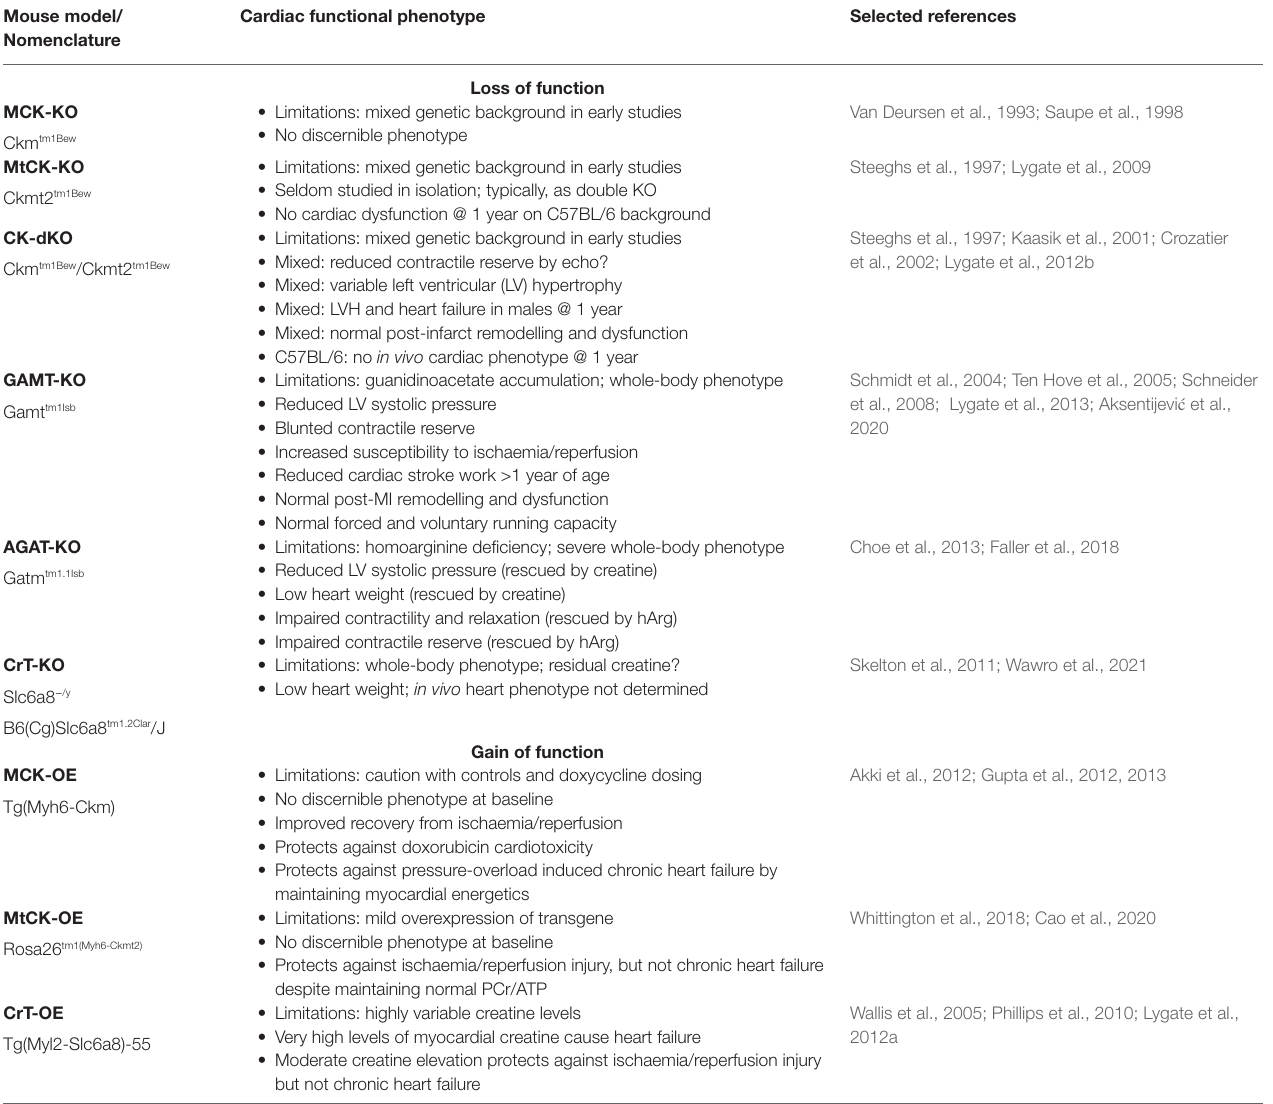
TABLE 2 | Genetically-altered mouse models affecting the creatine kinase